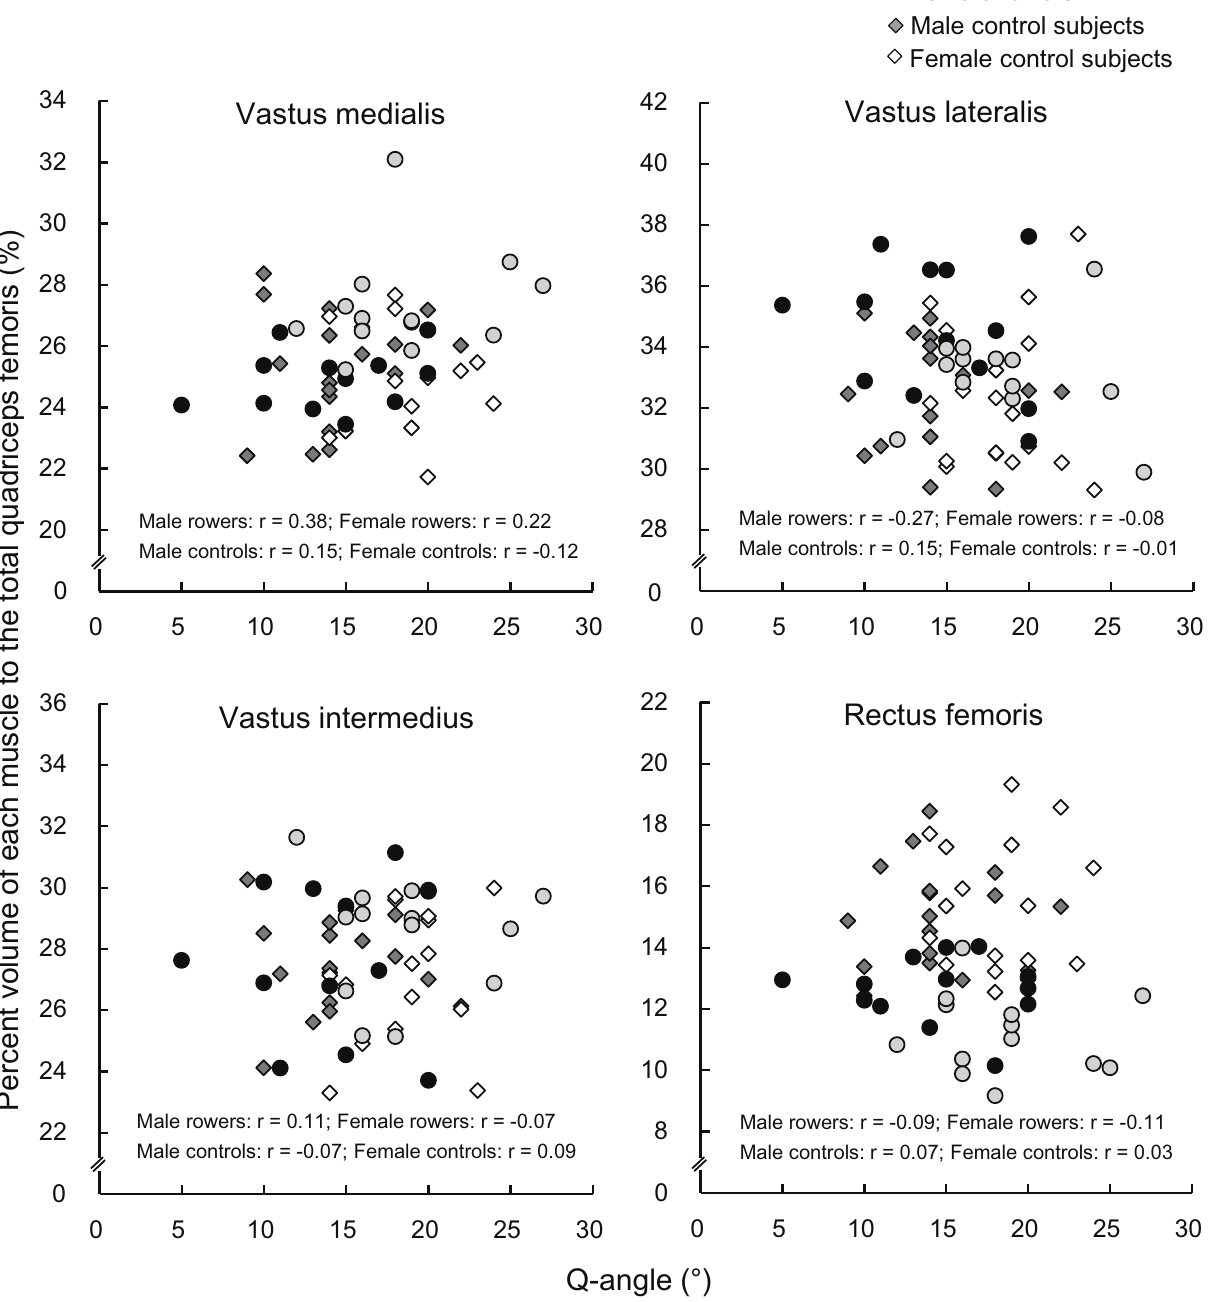
Fig 4. Relationship between Q-angle and percent muscle volume of each muscle to the total quadriceps femoris.